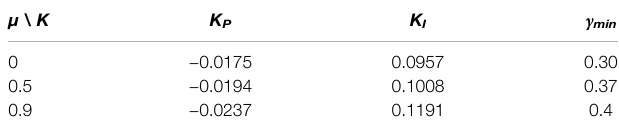
TABLE 6 | Controller gains for h (cid:2) 10 under different μ